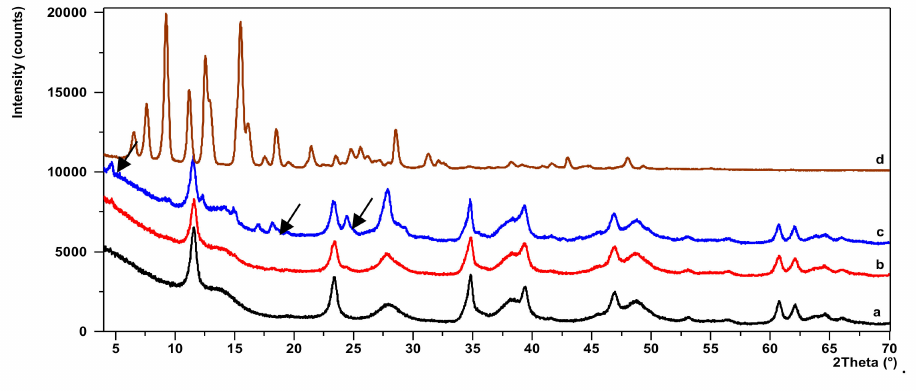
Figure 4. Diffraction patterns for AlMg − LH ( a ), AlMg − LH/AD 10% ( b ), AlMg − LH/AD 20% ( c ), and azo dye (AD) ( d ).